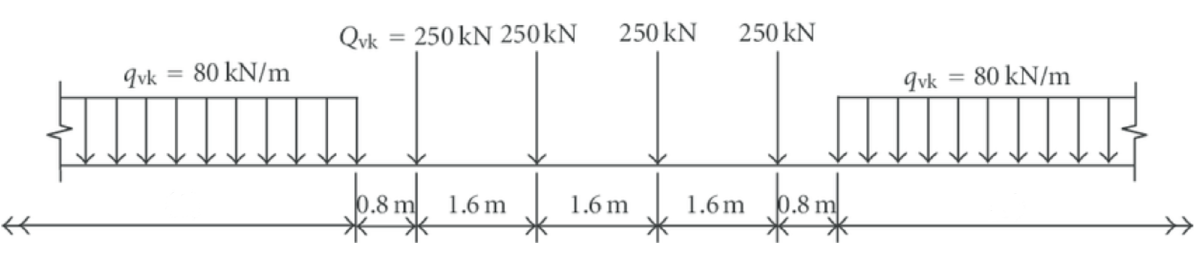
Figure 13: Load Model 71 and characteristic value for vertical load from Eurocode